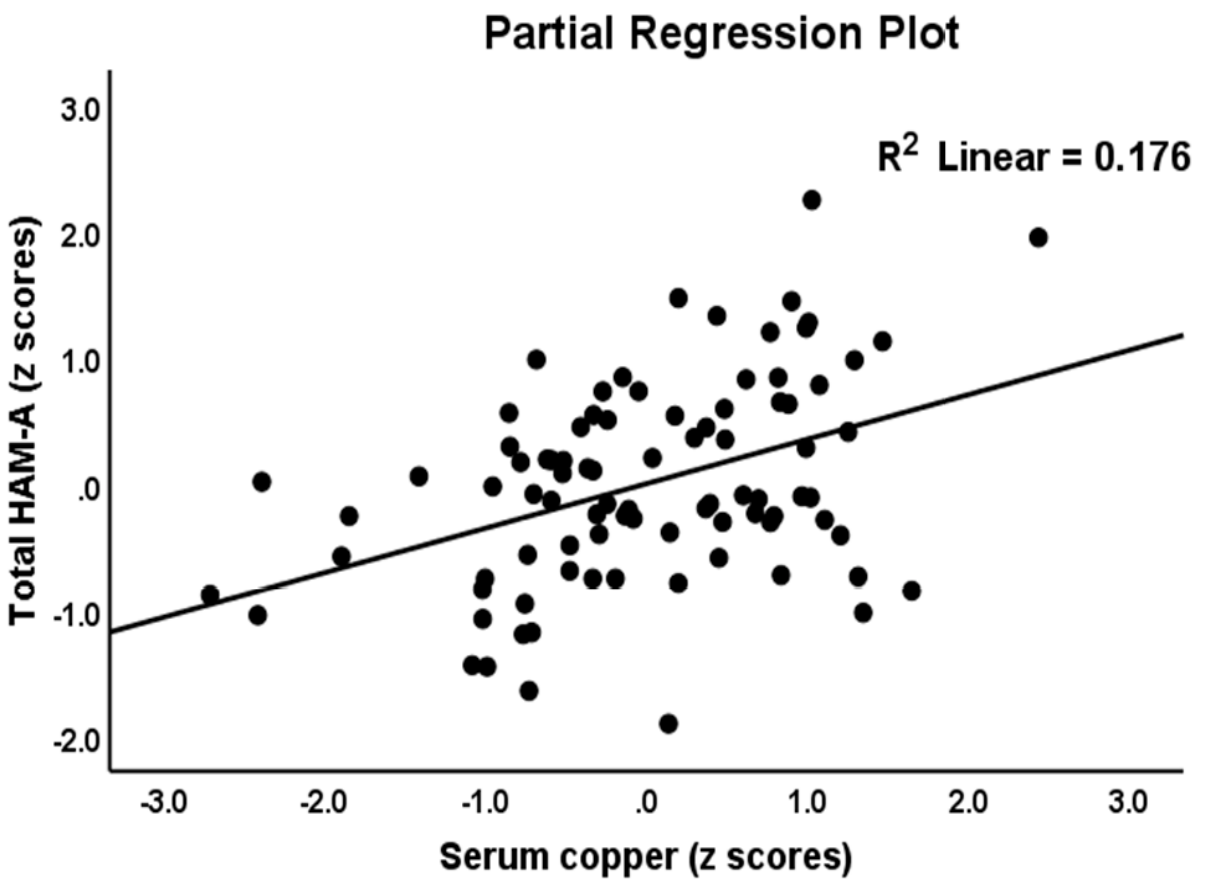
Figure 3. Partial regression plot with the Hamilton Anxiety Rating Scale (HAM-A) score as the dependent variable and serum copper as explanatory variable.